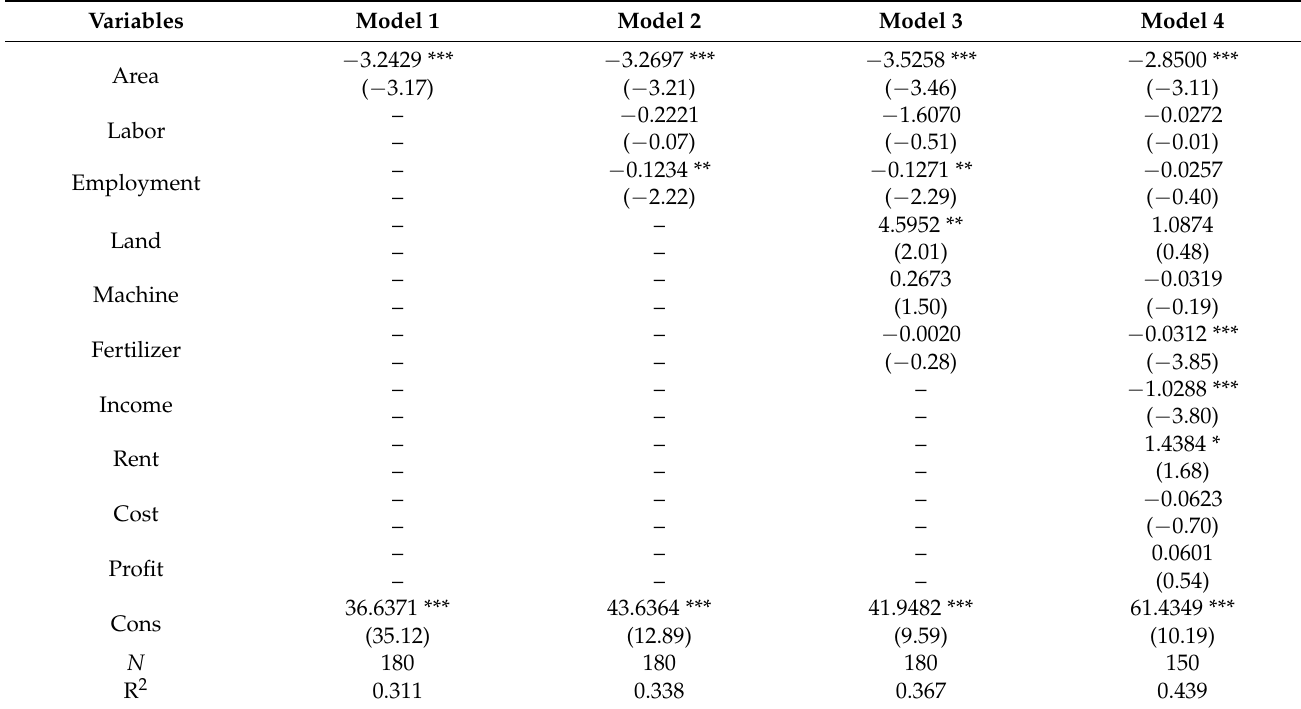
Table 4. Simulation results of the regression